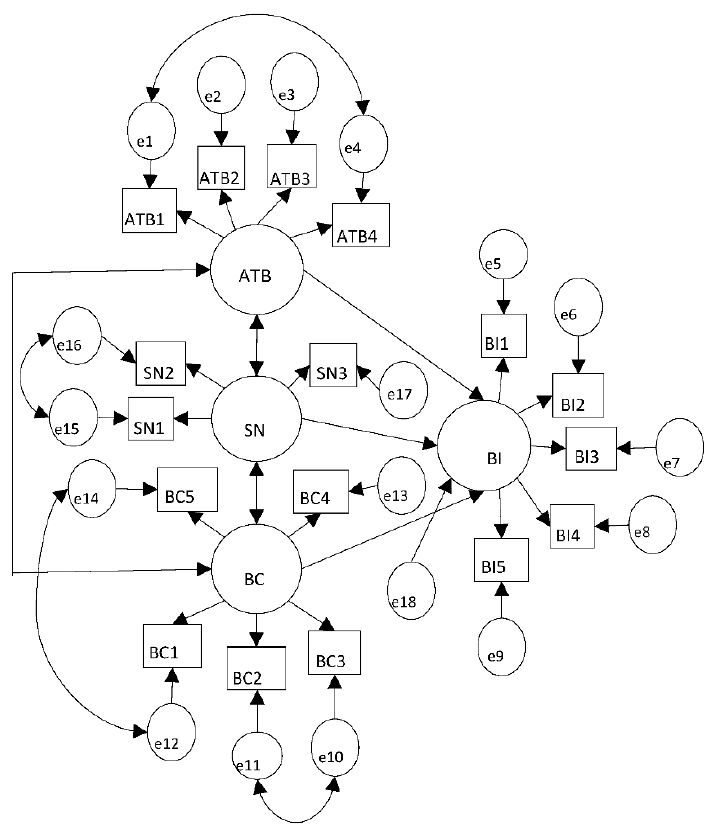
Figure 2. Modified model with additional correlations.